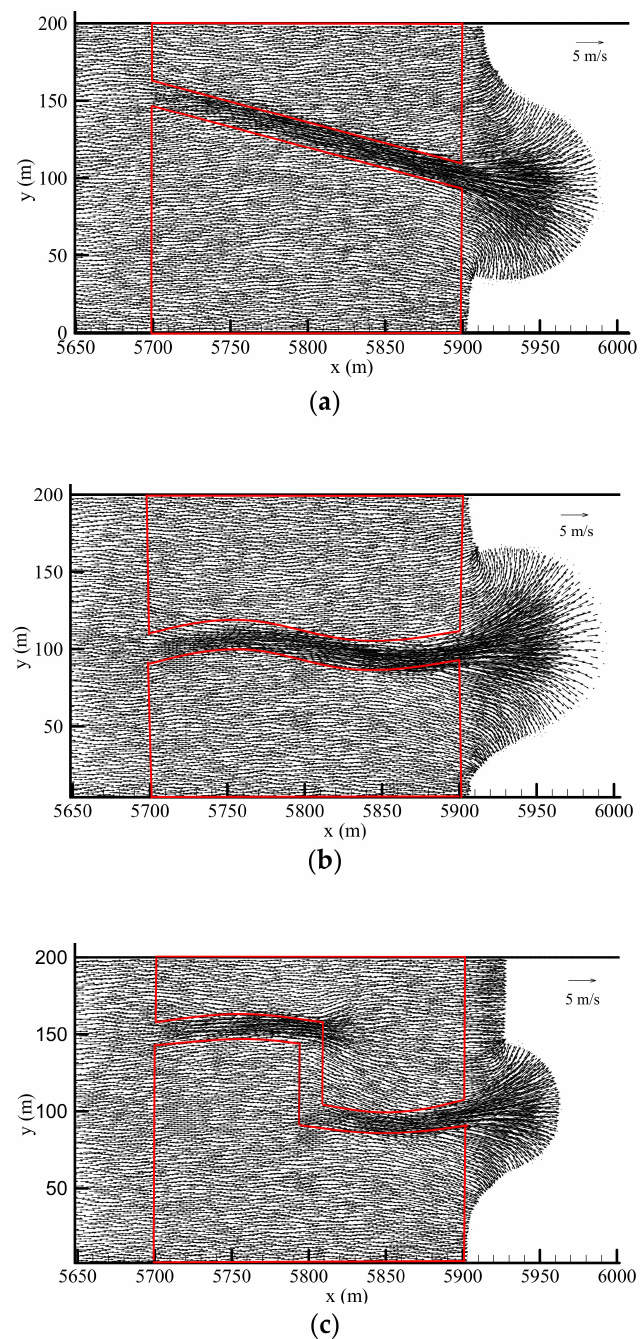
Figure 14. Flow structures at 660 s: ( a ) Case 2, ( b ) Case 3, and ( c ) Case